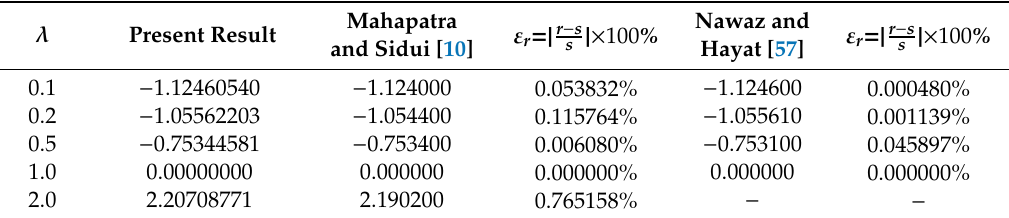
∗ ε r is the estimate percentage relative error between the present result, r and previous result, s .